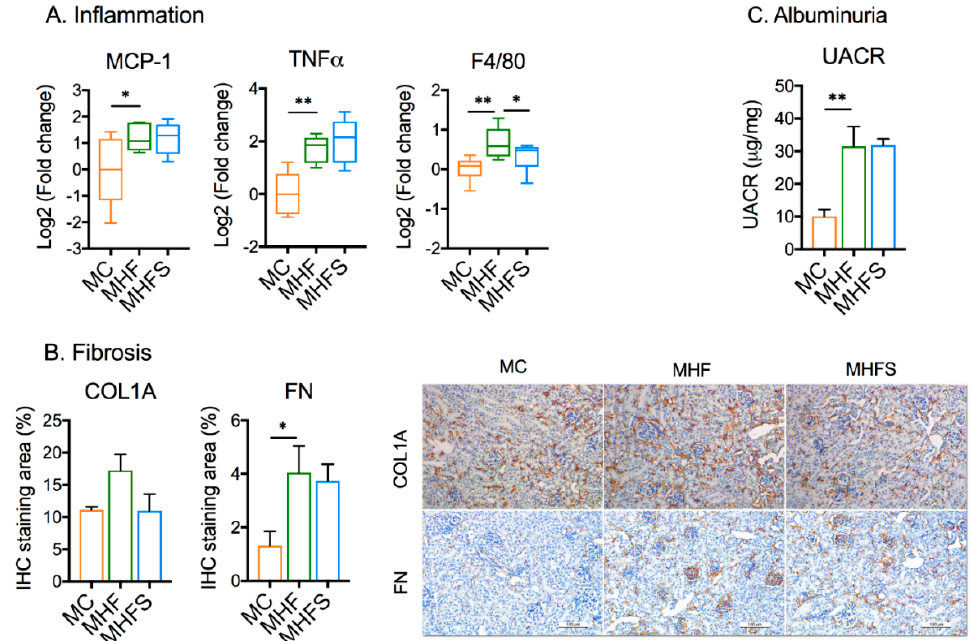
Figure 4. SIRT1 overexpression reduces markers of macrophage but not fibrosis and albuminuria in offspring born to obese dams. ( A ) mRNA expression of inflammation. ( B ) IHC staining quantification of fibrotic markers ( n = 6). ( C ) Urinary albumin creatinine ratio UACR ( n = 6). Data are presented as mean ± SEM or box plot (min to max, the central lines indicate the median). MCP: Macrophage chemotactic protein; TNF α : Tumour necrosis factor alpha; COL: collagen; FN: fibronectin. MC: offspring of chow-fed dams; MHF: offspring of HFD-fed dams; MHFS: MHF offspring with SIRT1 overexpression. * p < 0.05, ** p < 0.01.